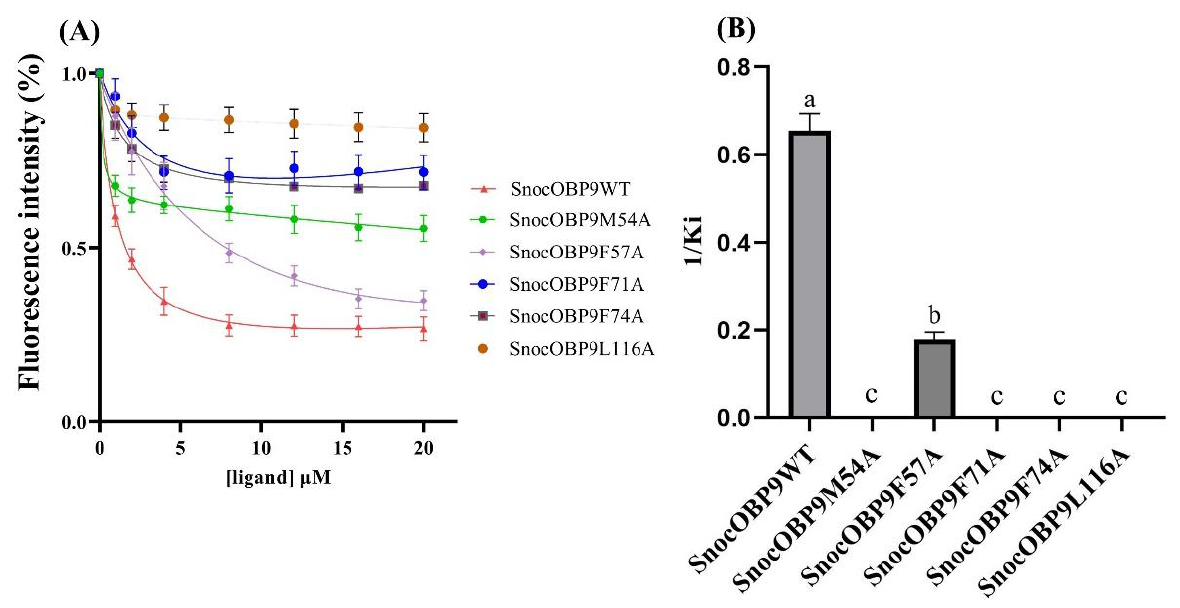
Figure 11. ( A ) Binding curve of SnocOBP9WT and mutant SnocOBP9 proteins. SnocOBP9WT represents the wild-type SnocOBP9 proteins. SnocOBP9M54A, SnocOBP9F57A, SnocOBP9F71A, SnocOBP9F74A and SnocOBP9L116A refer to MET54, PHE57, PHE71, PHE74 and LEU116 substitutions with ALA in SnocOBP9. ( B ) Comparison of the binding affinities (indicated by 1/Ki) for wild-type (WT) SnocOBP9 and SnocOBP9F57A to Z3D. Different letters indicate significant differences between SnocOBP9WT and SnocOBP9F57A (p < 0.05, ANOVA, Tukey’s HSD).